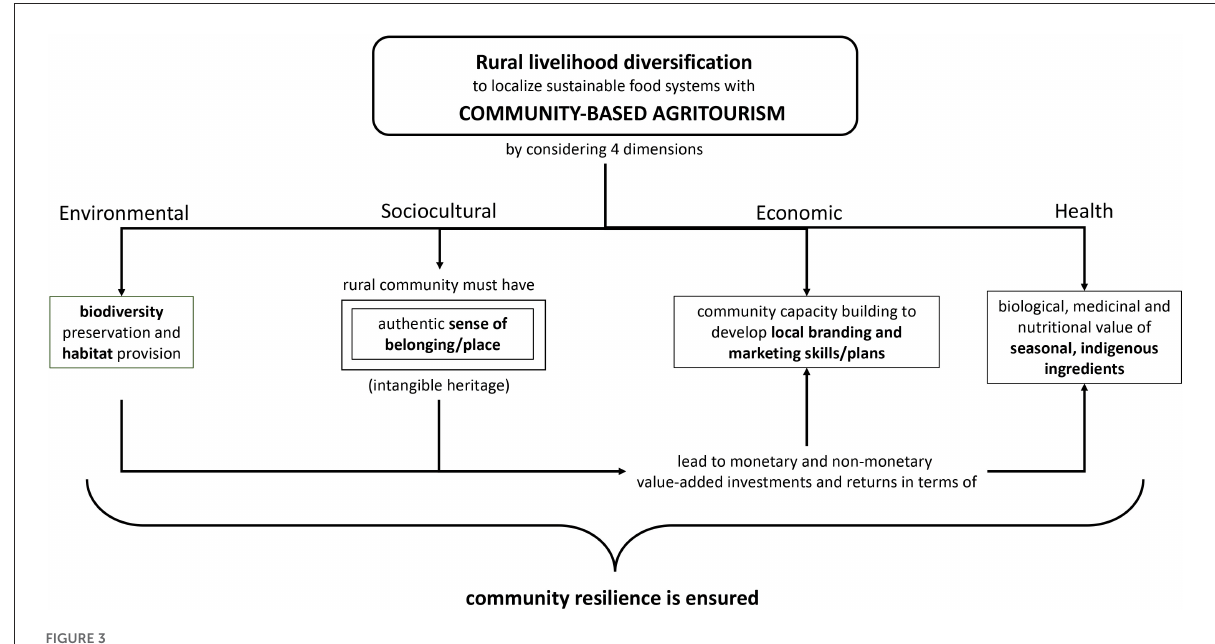
FIGURE3 Analytical framework (source: